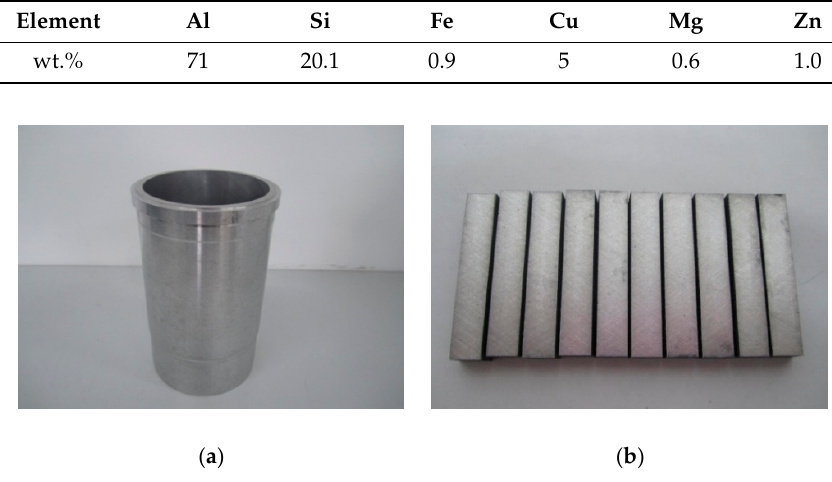
Figure 1. Al–Si alloy cylinder liner and samples. ( a ) Cylinder liner; ( b ) cylinder liner samples.